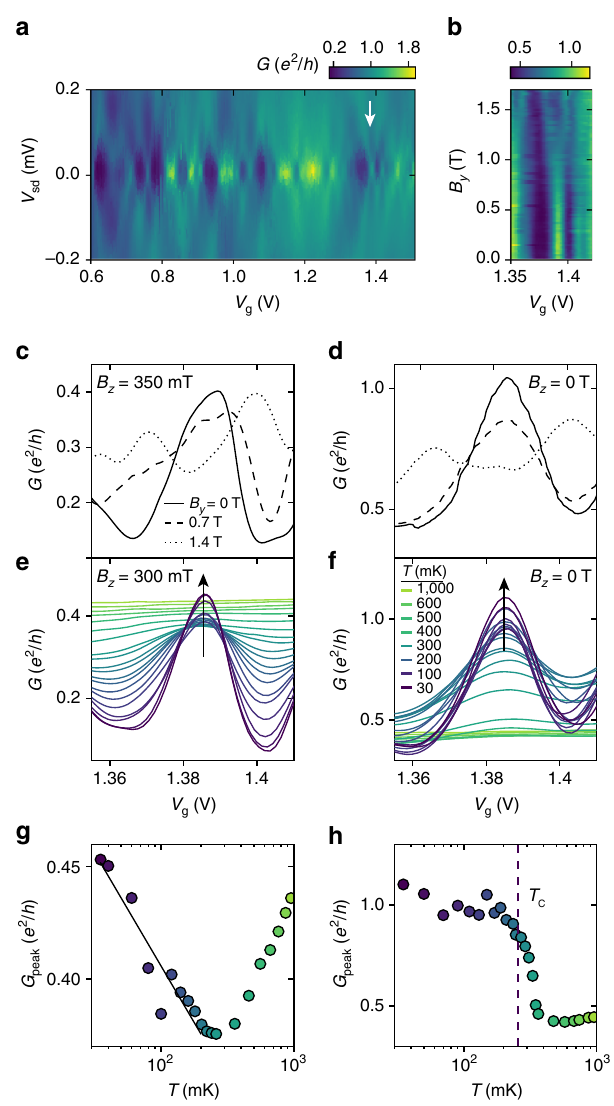
Fig. 4 Transport characteristics of the strong tunneling regime. a Bias spectroscopy of the conductance G ( V g ) in the strong coupling regime V g > 0.6 V for B = 0, showing diamond-shaped regions of suppressed conductance. The zero-bias resonance at the gate voltage indicated by the white arrow is studied for varying in-plane magnetic fi eld B y b – d and temperature e , f with and without out-of-plane magnetic fi eld B z > B z suppress superconductivity in the leads. In e , f the arrows emphasize the temperature dependence of the peak conductance. g Extracted peak height from f , fi tted to − log( T ) ( black line ). h Extracted peak height from e with T c of the leads ( dashed line ) found from independent measurements of the